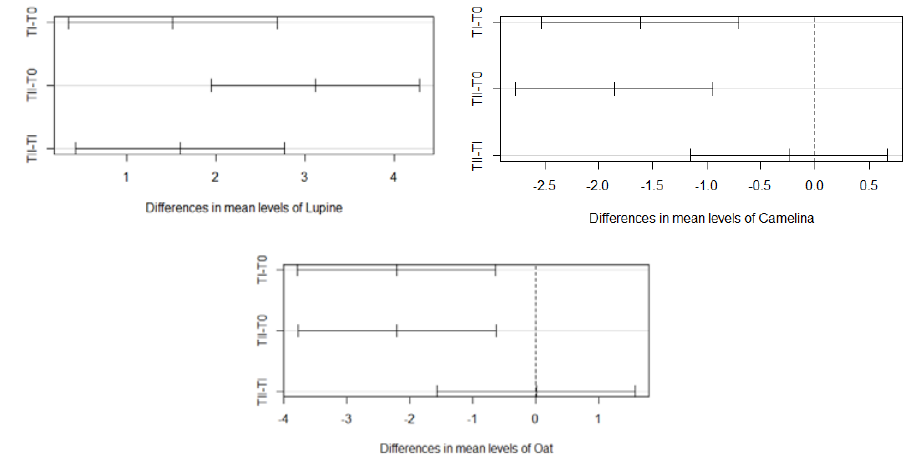
Figure 5. The 95% family-wise confidence levels for nickel amounts in cultivated plants (lupine, camelina, and oat) in dependence on treatments (T0, TI, TII) .